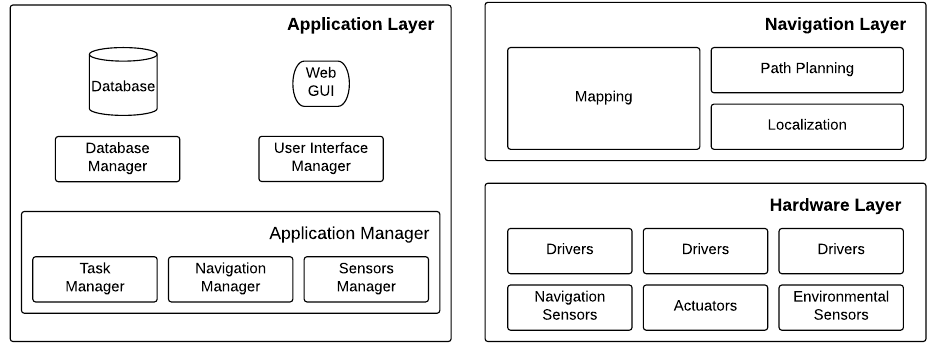
Figure 3. Functional architecture of the proposed